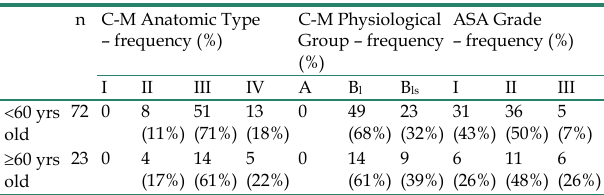
Table 4 : Cierny- Mader (C -M) Staging and ASA Grades for the <60 years and ≥ 60 years old age